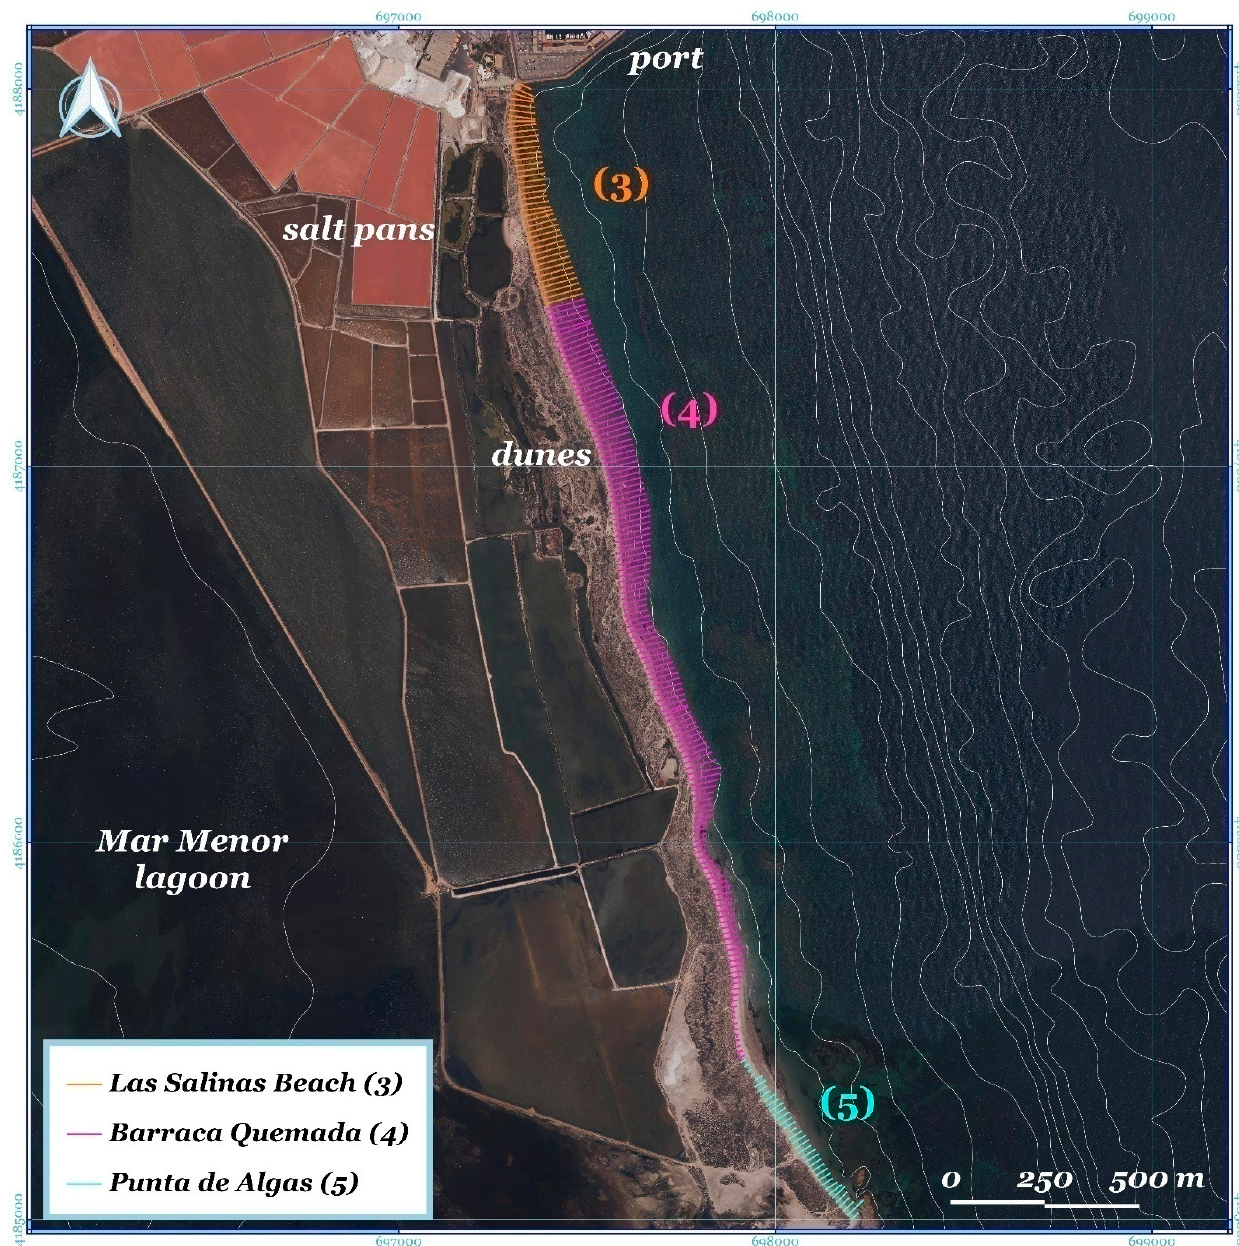
Figure 5. Sections located south of the Port of San Pedro del Pinatar. Las Salinas Beach (3), Barraca Quemada Beach (4), and Punta de Algas Beach (5). Source: own elaboration.